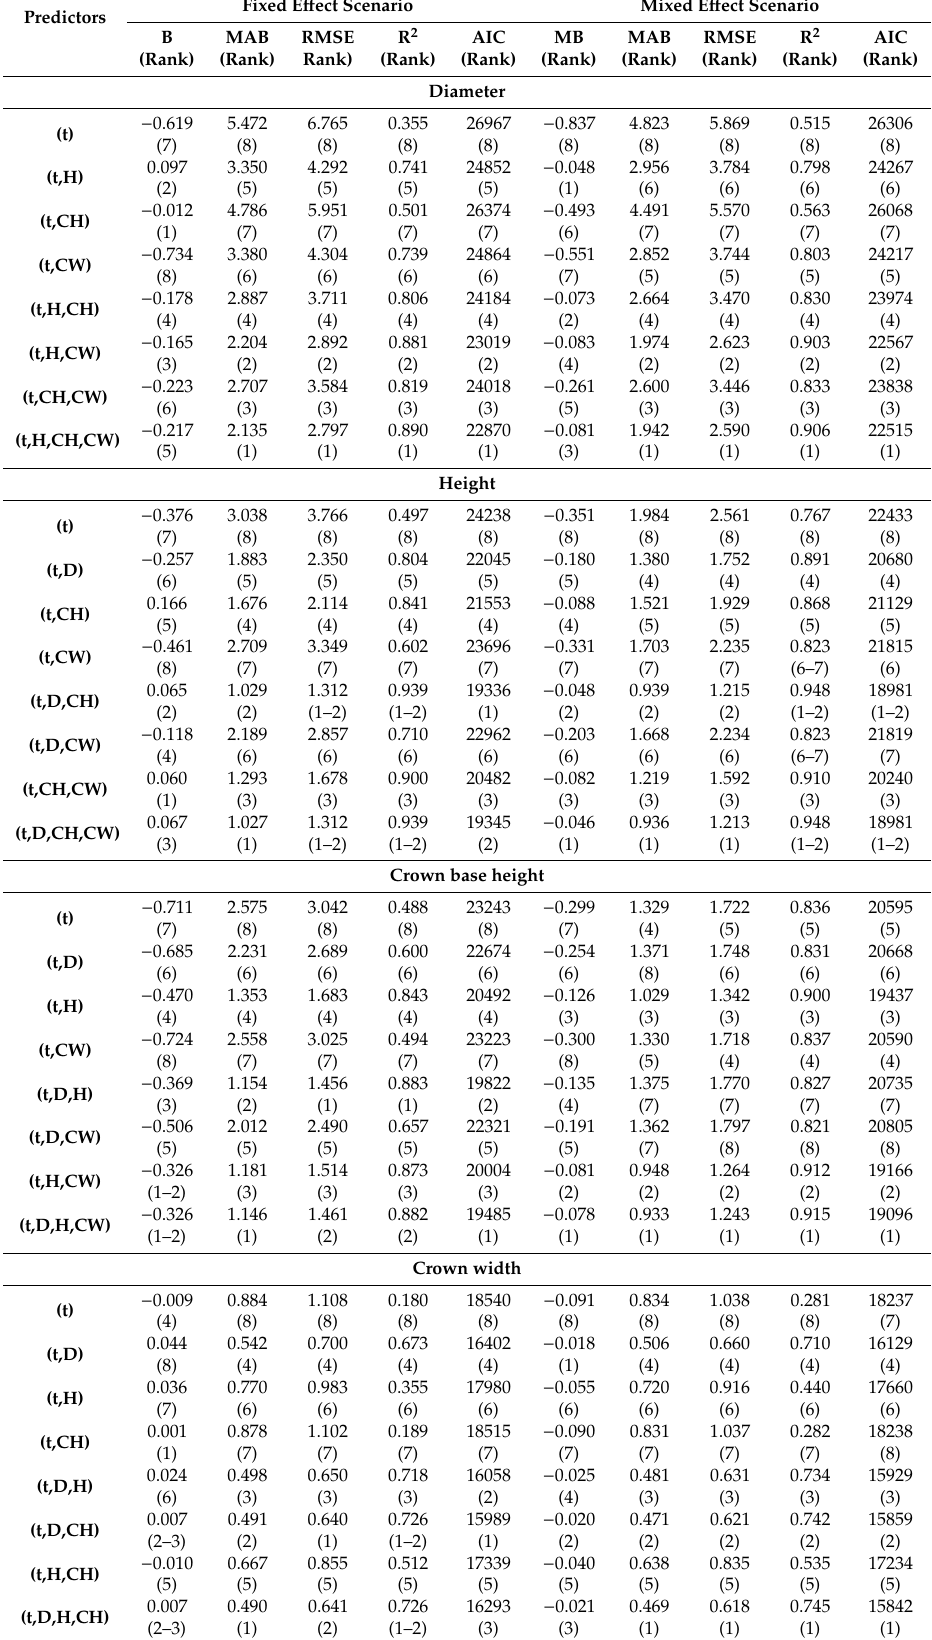
Table 2. Goodness-of fit numerical statistical measures for the fixed- and mixed e ff ects scenario models.